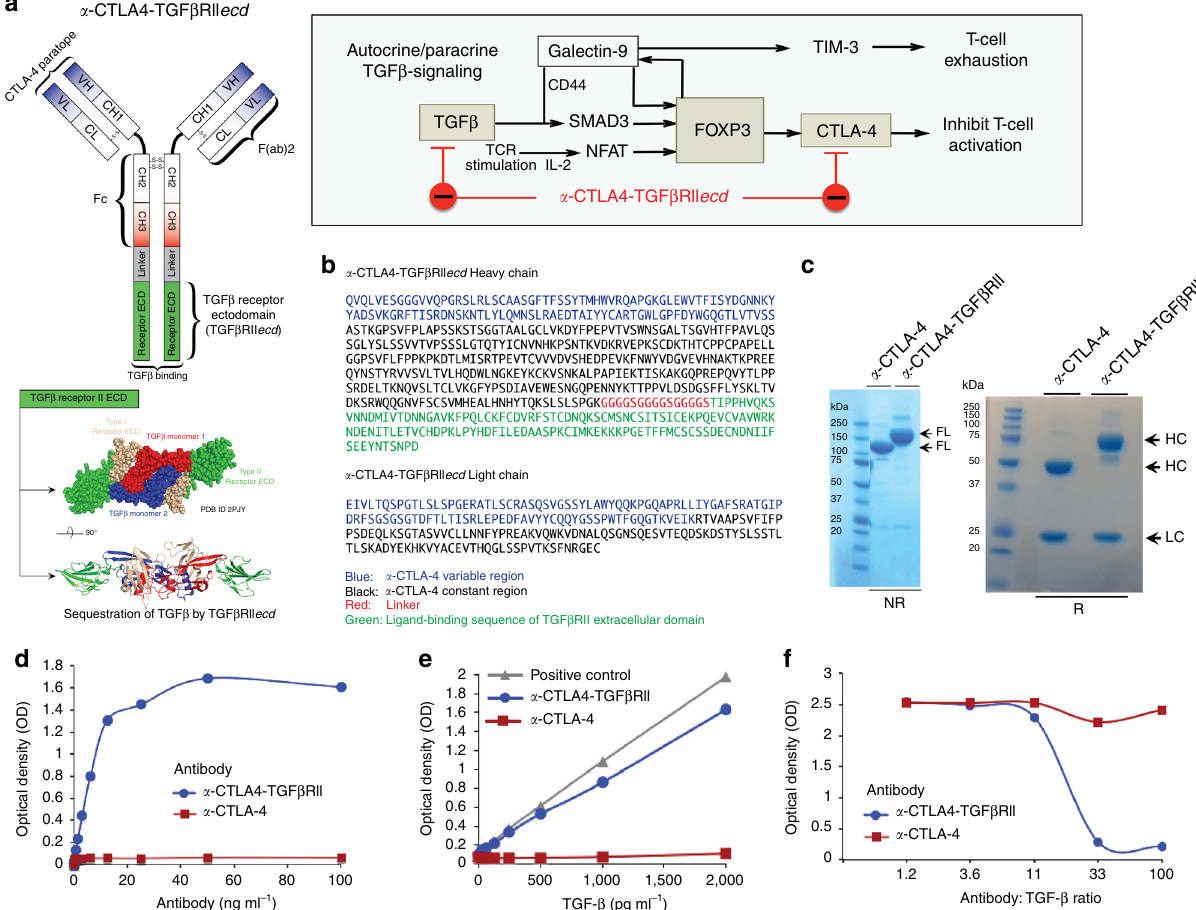
11 Antibody: TGF- β ratioTGF- β (pg ml –1 ) Fig. 2 Design and bifunctional target binding ability of a -CTLA4-TGF β RII. a Autocrine/paracrine TGF β -induced expression of FOXP3, the signature transcription factor of the Treg lineage. FOXP3 induces the expression of CTLA-4 and Galectin-9, a ligand that engages TIM-3 and triggers exhaustion or apoptosis of effector T cells. Galectin-9 further interacts with TGF β receptors to drive FOXP3 expression in a positive-feed forward autocrine loop involving SMAD3 activation to induce and maintain Tregs. Schematic representation of the structure and targets of a -CTLA4-TGF β RII are shown. a -CTLA4-TGF β RII was designed by fusing the C terminus of the heavy chain of a human a -CTLA-4 antibody with a ligand-binding sequence of the extracellular domain of TGF β Receptor II (TGF β RII ECD) via a fl exible linker peptide, (GGGGS) 3 . b Amino acid sequences of the heavy chain and light chain of a -CTLA4-TGF β RII. c SDS-PAGE (unreduced-NR and reduced-R) comparing the molecular weight of a -CTLA4-TGF β RII and a -CTLA-4 antibody (FL, full-length; HC, heavy chain; LC, light chain). d , e Bifunctional ability of a -CTLA4-TGF β RII to simultaneously bind CTLA-4 and TGF β 1 using a ‘ double-sandwich ’ ELISA, wherein a -CTLA4- TGF β RII or a -CTLA-4 antibody was added to CTLA-4-Fc-coated plates, followed by rhTGF β 1 that was detected by a biotinylated anti-human TGF β 1 antibody. TGF β RII-Fc-coated plates were used as a TGF β -binding positive control. f Standard ELISA showing the ability of a -CTLA4-TGF β RII to compete with a TGF β capture antibody for binding to TGF β 1. For d – f , the data show the optical density (OD) values (mean of three replicate wells for each assay condition) from a representative of two independent